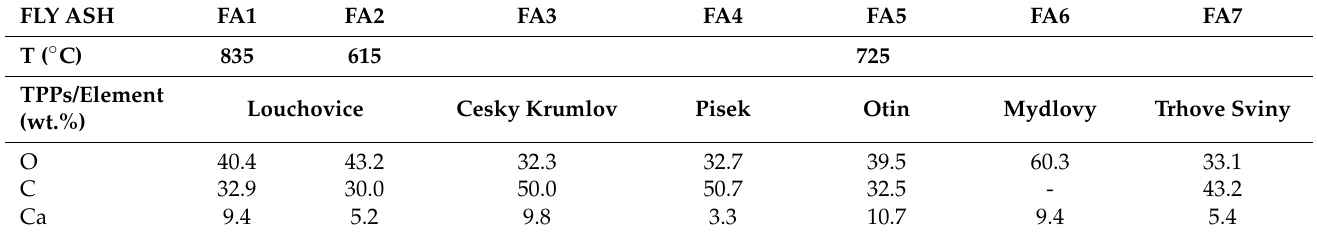
Table 4. Laser beam particle size analysis of fly ashes (Volume, Number, Surface, Rosin-Rammler). and parameters (D10, D50, D90, Mean Size, Span, D [5,3]).